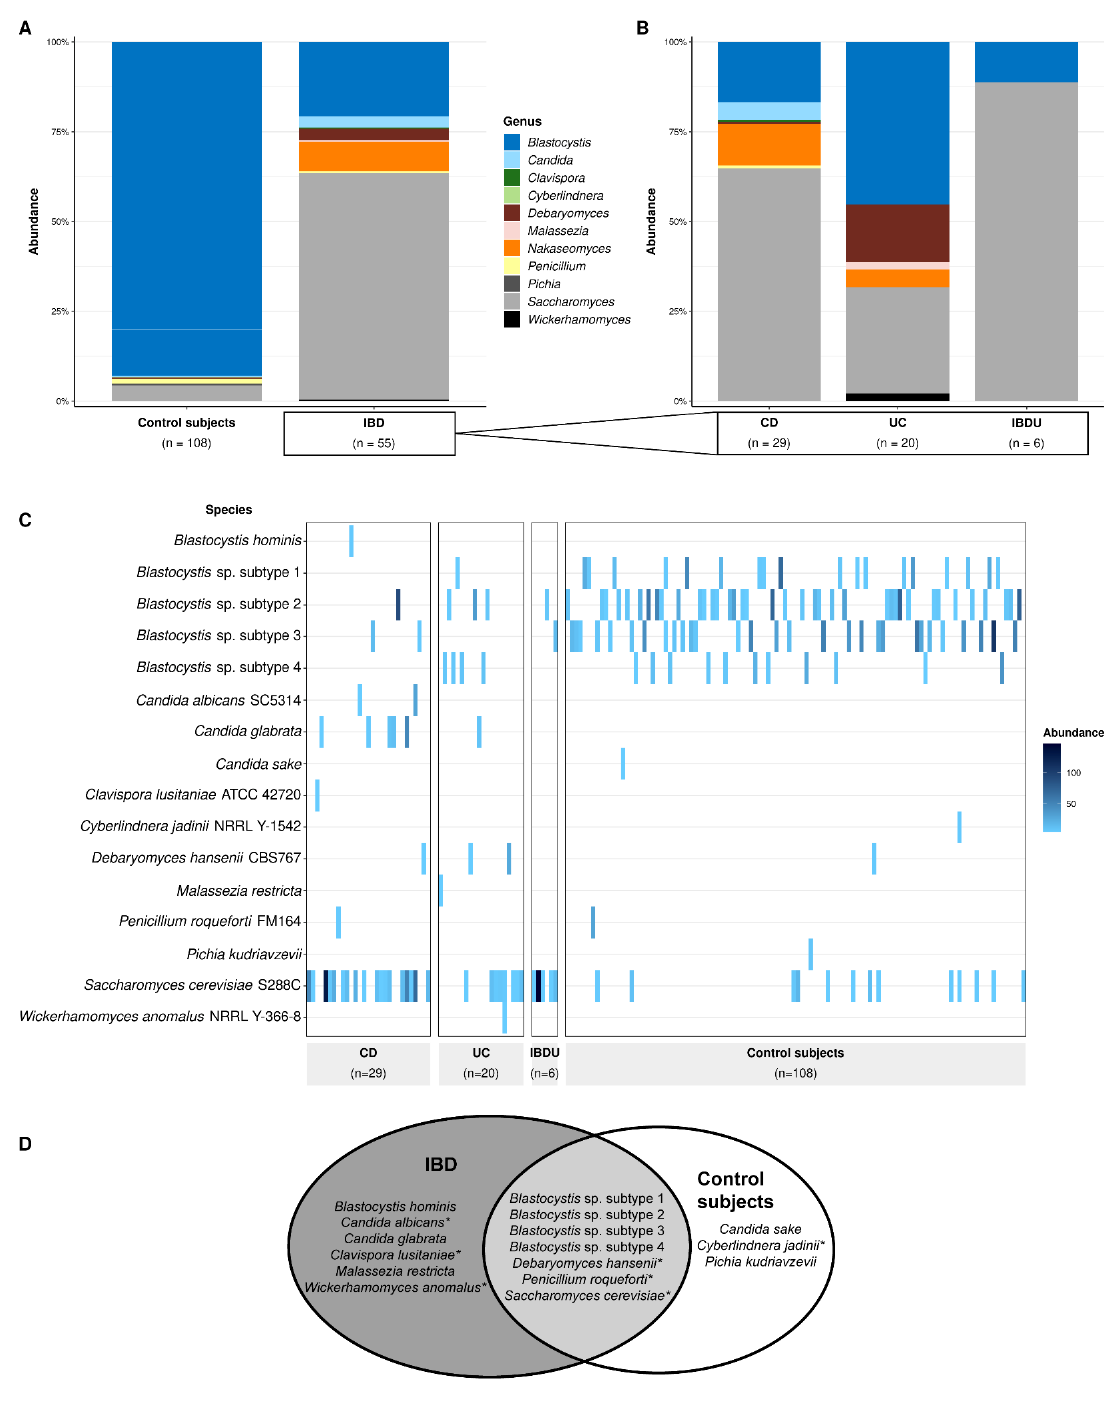
Figure 2. The prevalence and distribution of microbial eukaryotes in shotgun stool metagenomes is shown in people with inflammatory bowel disease (IBD) ( n = 355) and unaffected healthy people (control subjects) ( n = 471). ( A ) Total proportional abundances of microbial eukaryotes detected at the species-level in control subjects ( n = 108) and individuals with IBD ( n = 55); ( B ) Total proportional abundances are also broken down for all the people with IBD into each of their IBD subtypes—Crohn’s disease (CD) ( n = 29), ulcerative colitis (UC) ( n = 20), and IBD unclassified (IBDU) ( n = 6); ( C ) Distribu- tion and abundances of microbial eukaryotes detected at the species-level in people with IBD, specified by their IBD subtype, compared to the control subject group ( n = 108); ( D ) Eukaryotic species unique